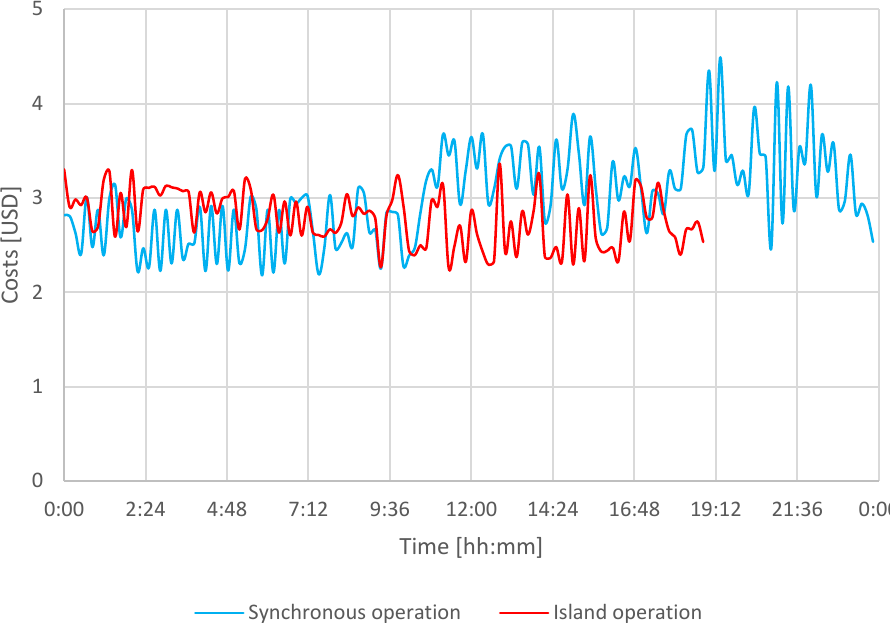
Figure 7. Daily changes of active power losses.